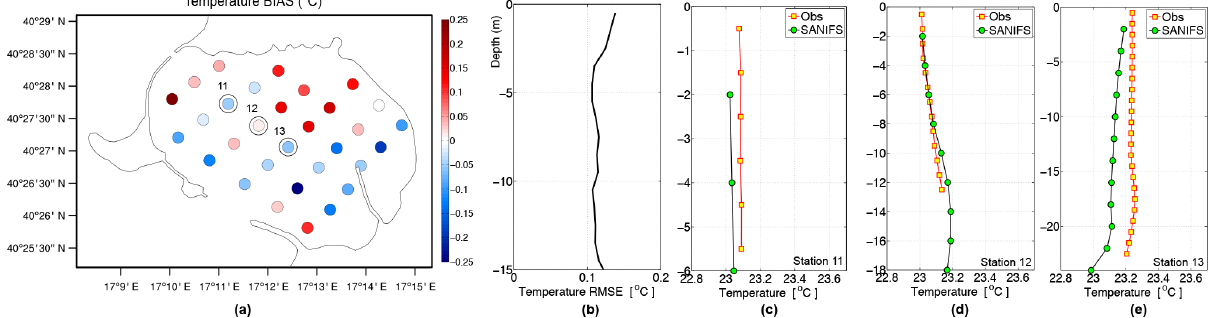
Figure 10. Bias of surface temperature (a) and RMSE profile (b) for CHS campaign. Comparisons between modelled (green circles) and observed (yellow squares) profiles for casts 11 (c) , 12 (d) and 13 (e) .